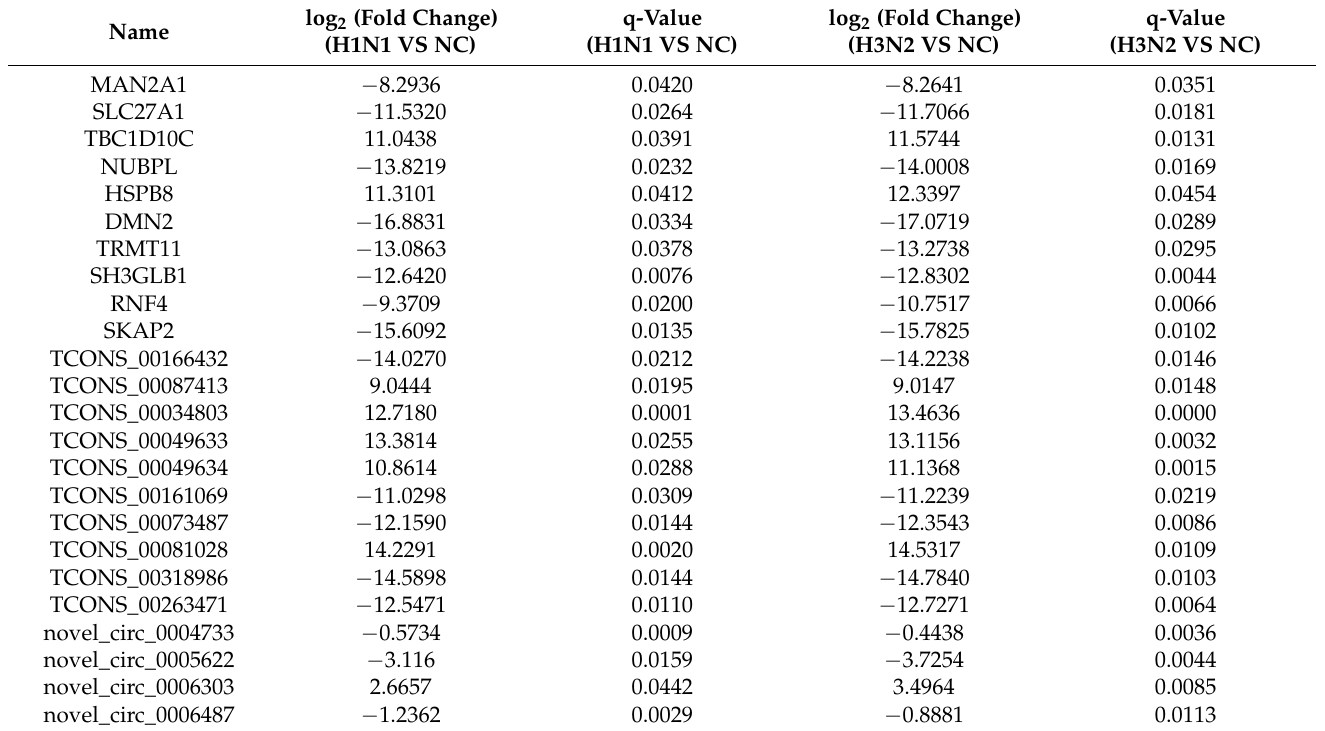
Table 1. Partially common differential mRNAs, lncRNAs, circRNAs and